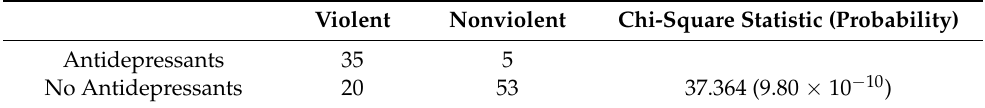
Table 4. Chi-square test of the use of antidepressants.